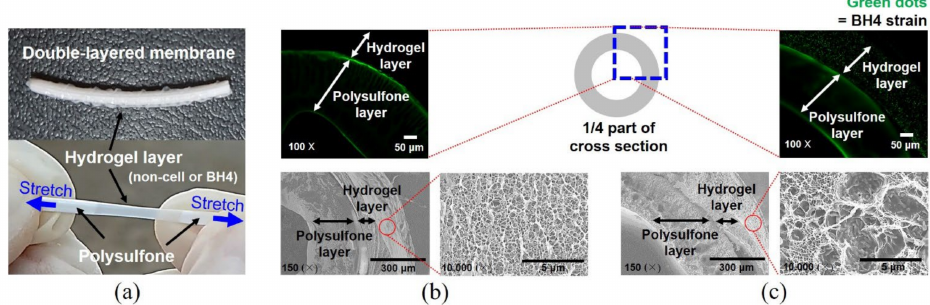
Figure 3. Double-layered composite membranes. ( a ) A photo of the double-layered membrane (i.e., hydrogel) and inner (i.e., polysulfone) layers. Visualization (CLSM and SEM) of ( b ) BH4-free layered membrane and ( c ) BH4-embedded layered membrane. The fluorescent dye (Syto 9) was used for staining the BH4 cells, which are shown in green dots in ( c ). The membrane edge looks green due to dye